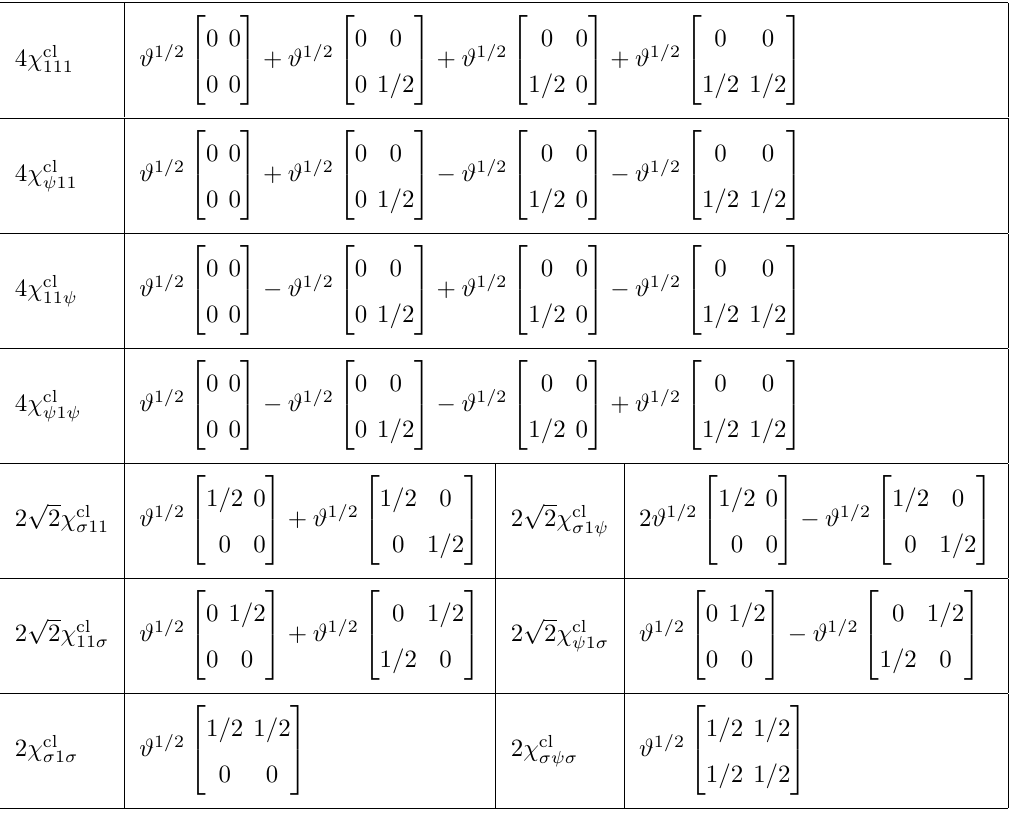
Table 1 . The correspondence between (the classical parts of) Ising characters (left) and free fermion characters